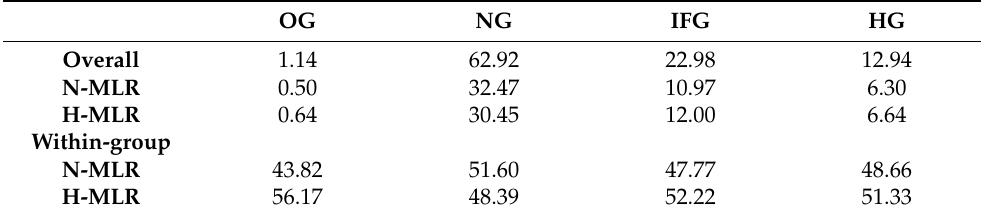
Table 1. Prevalence of glycemic disturbances relative to MLR.